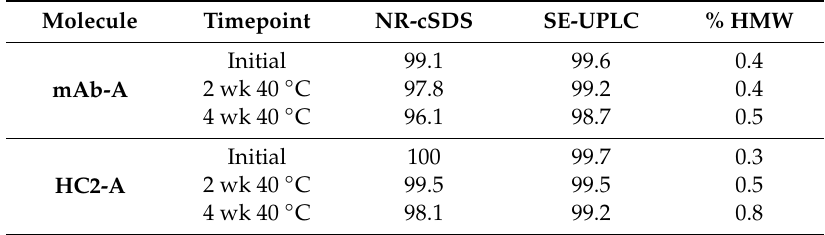
Table 4. Formulation conditions were 5 mg / mL for both mAb-A and HC2-A in 20 mM sodium acetate pH 5.5, a representative formulation condition. Both samples were stored up to 4 weeks at 40 ◦ C. Column representations are % purity by NR-cSDS, % purity by SE-UPLC, and % High Molecular Weight species (HMW) quantified by SE-UPLC. Molecules were purified by ProA a ffi nity chromatography followed by SEC